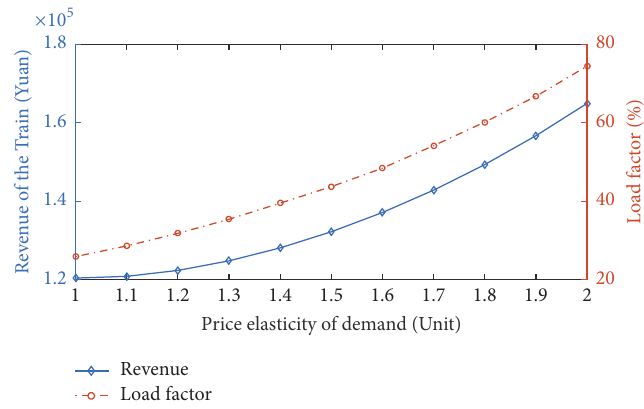
Figure 3: Relation between optimal fare scheme and price elasticity of demand.